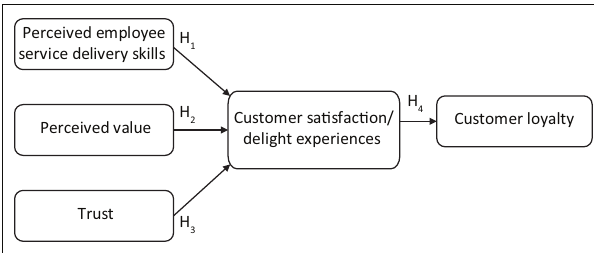
FIGURE 1: Proposed conceptual